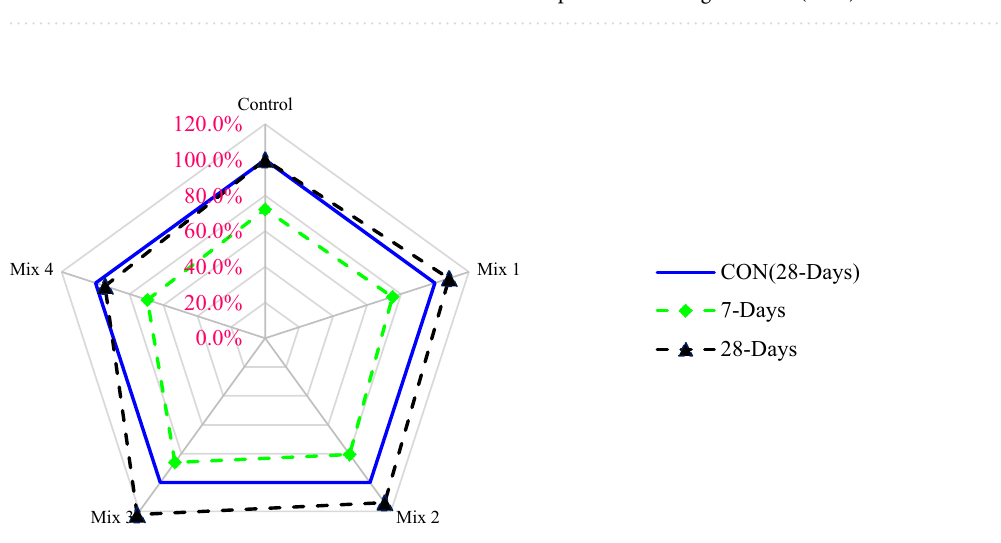
Table 8. Standard deviation and coeffiecient of variation of split tensile strength results (MPa).